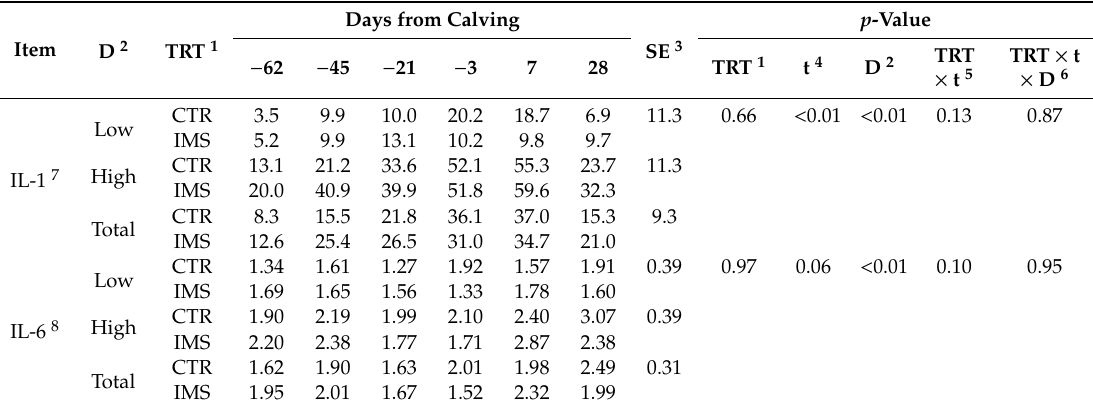
Table 5. Fold change values (expressed with respect to baseline) of cytokines in a whole blood stimulation assay with a low or high dose of bacterial lipopolysaccharides in control dairy cows (n = 5) or cows